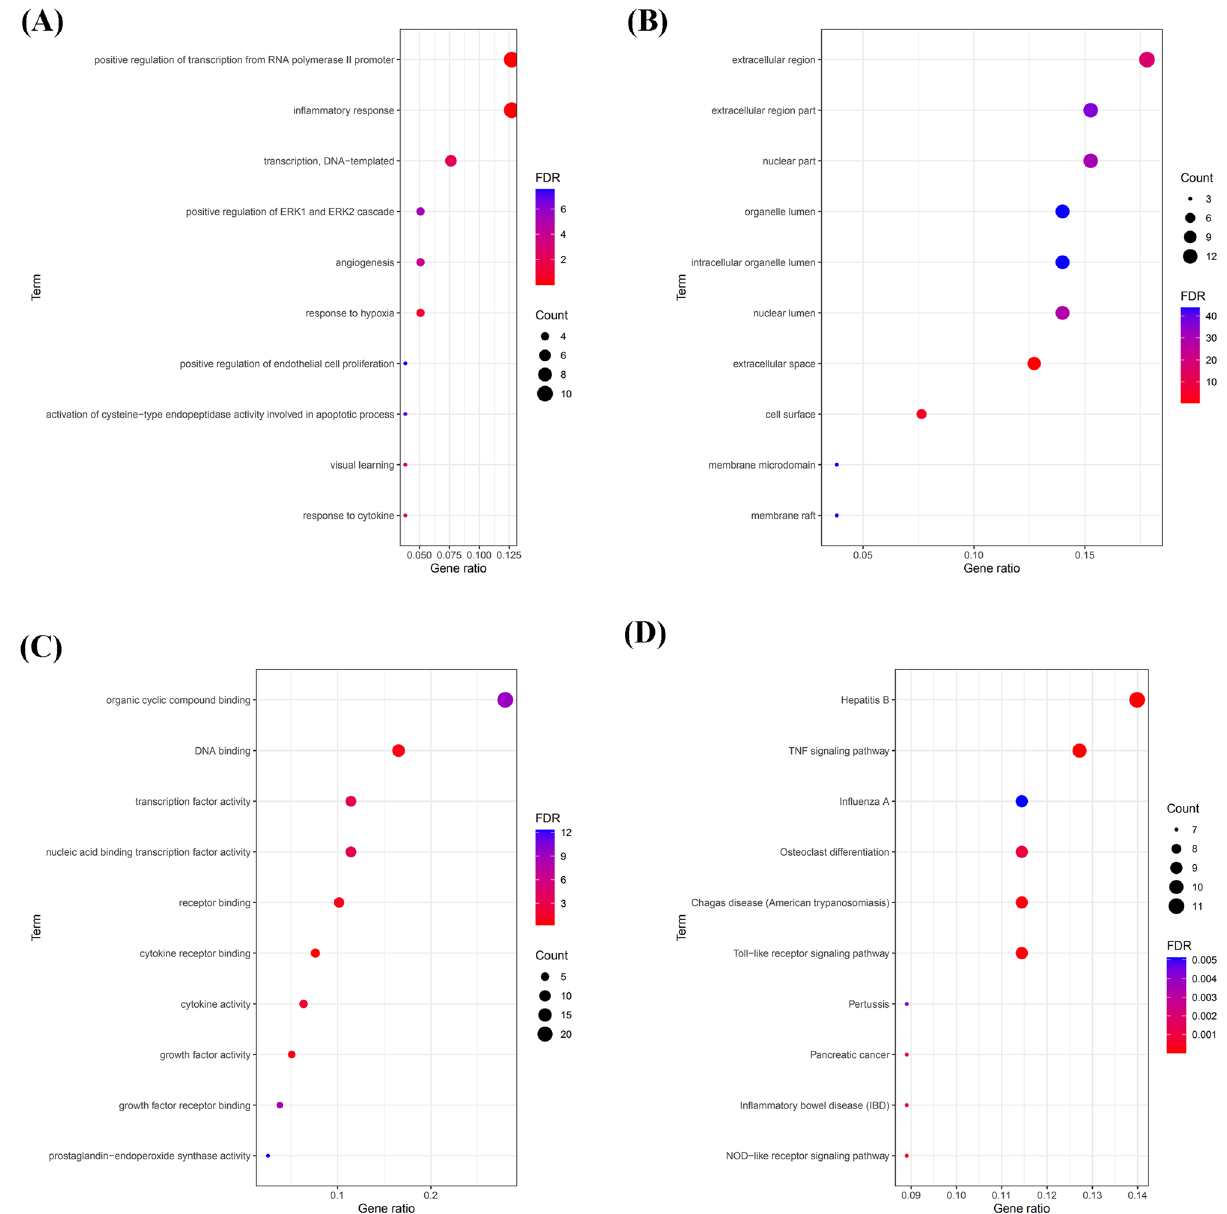
Figure 3. Functional enrichment analysis. ( A ) Biological process (BP); ( B ) cellular component (CC); ( C ) molecular function (MF); and ( D )